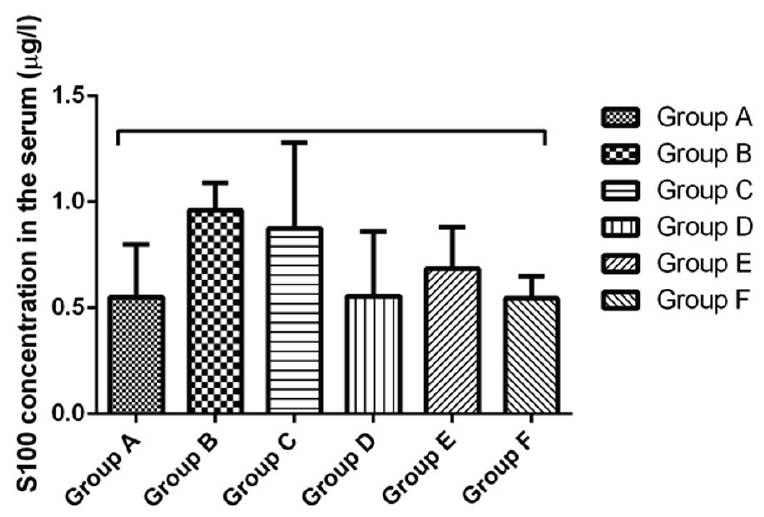
Figure 5. Erythema (in A.U. as determined by the manufactured device) in the different experimental groups on day 21 of the experiment. * p < 0.05, *** p < 0.001.